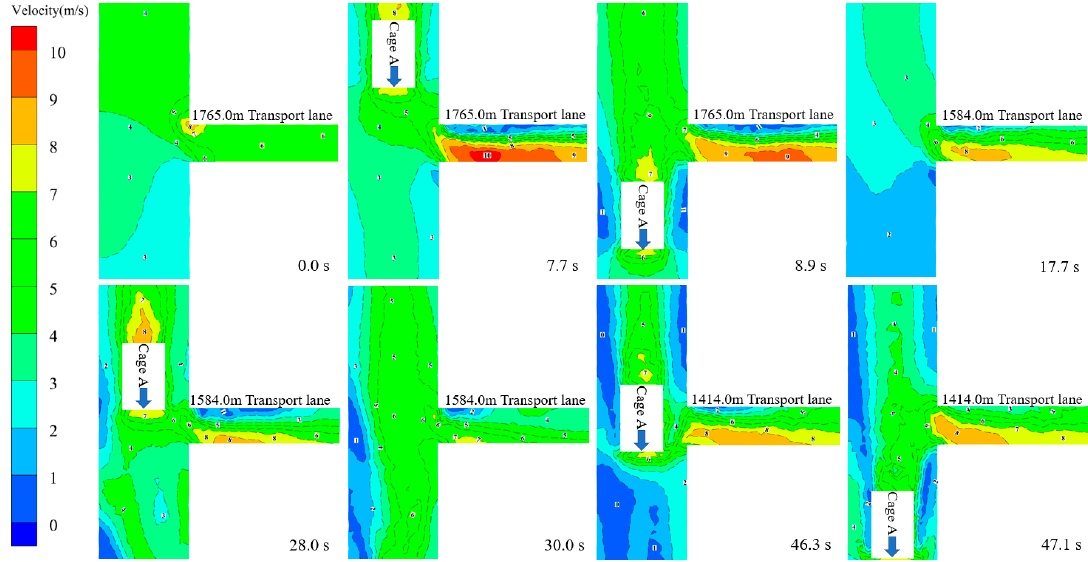
Figure 8. Velocity field distribution of each transport lane in x = 1 m section.